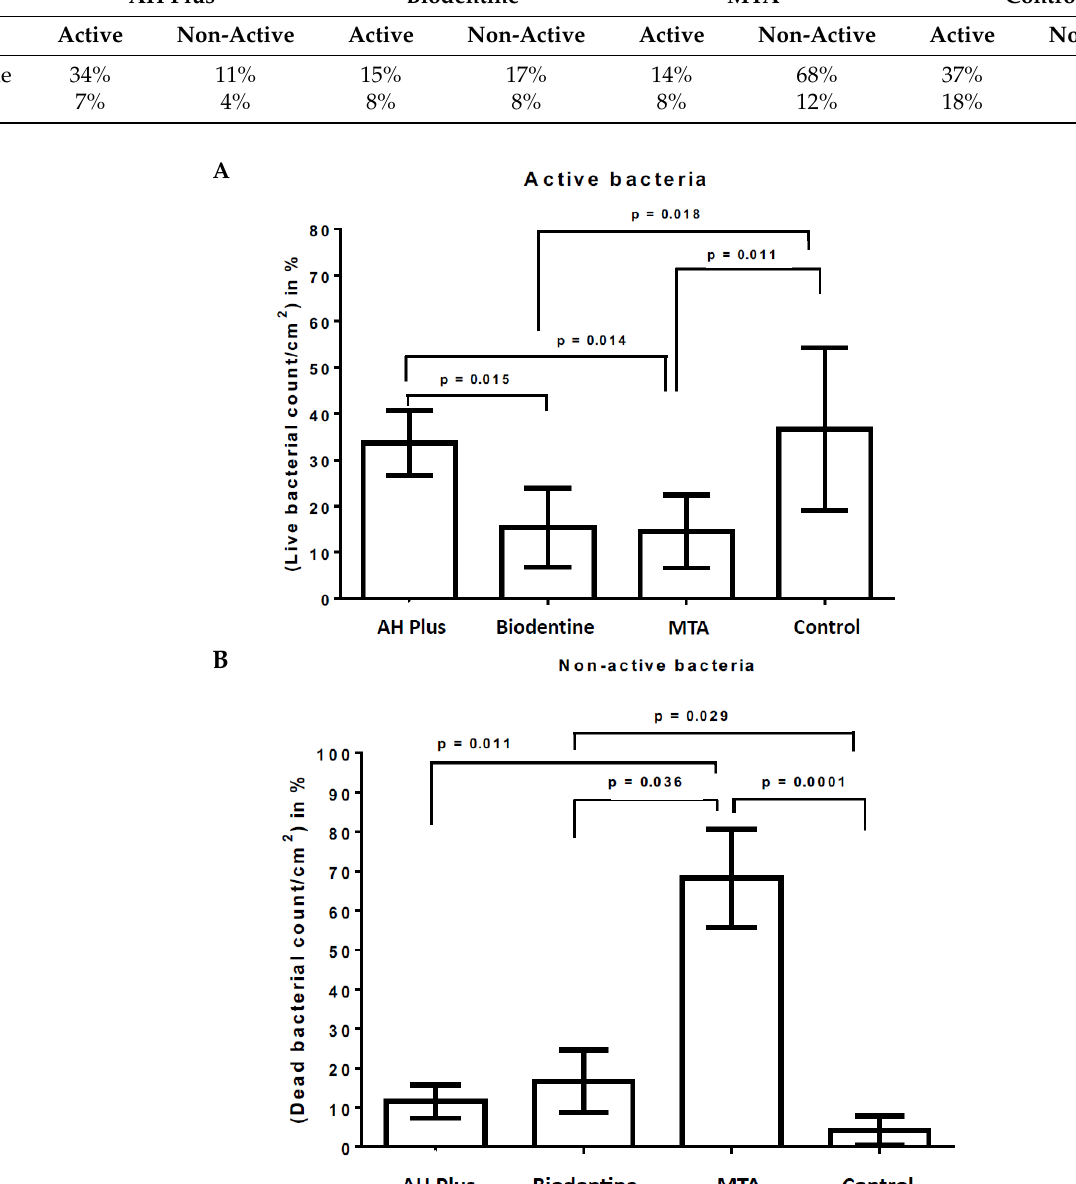
Figure 5. Fluorescence microscopy images after live/dead staining with BacLight ® . The vital (active) bacteria fluoresce in green, the avital (non-active) in red. The initial adhesion (2 h) is depicted on bovine dentin (control) ( A ), MTA (B), Biodentine ( C ), and AH Plus ( D ). 3. Discussion In the present study, significant differences in the initial adhesion of oral microbiota (2 h) were found for the materials tested (AH Plus, Biodentine, MTA). The control, namely bovine dentin, seems to be the most favorable surface for microbial adhesion and micro- bial viability among the materials tested. In contrast, MTA and Biodentine appear to have